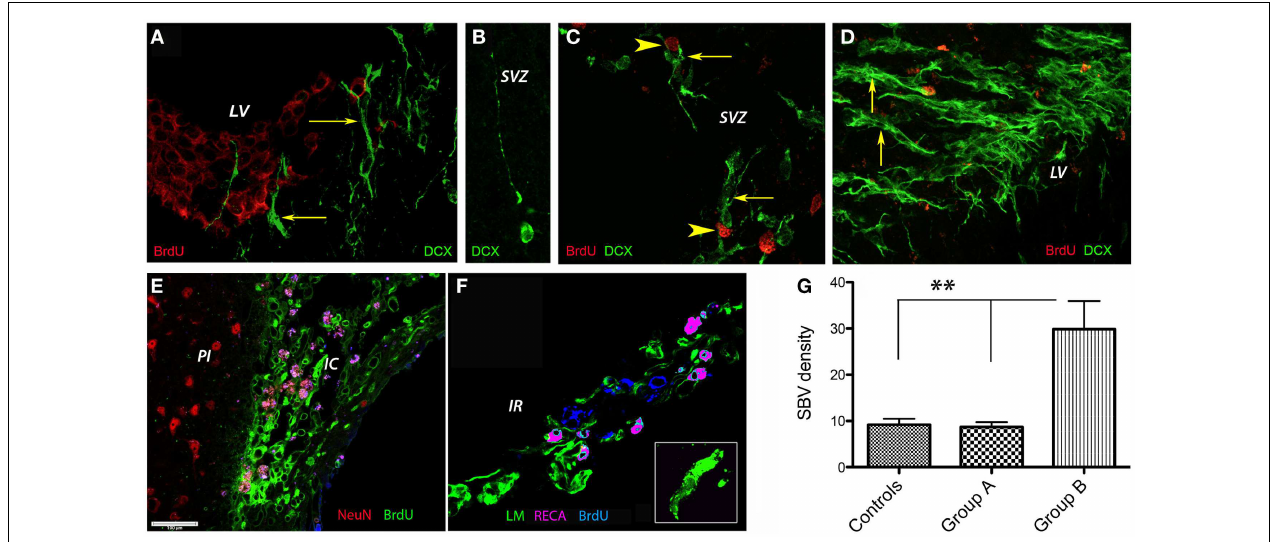
green].The border to the healthy brain region was abruptly demarcated to the left by NeuN-positive nuclei [ (E) , red]. Beyond the formerly infarct core, we noted vigorous sprouting angiogenesis as evidenced by RECA/BrdU double positive blood vessels [ (F) , violet] as well as numerous BrdU + nuclei in the newly formed endothelium [ (F) , blue] and reconstruction of the basal lamina [ (F) , green] during the resolution phase of angiogenesis. By number of laminin/BrdU co-localizations, the density of the newly formed blood vessels was significantly higher (threefold, p = 0.01) in the brains of animals treated with the combination G-CSF + BM MSC as compared to controls and G-CSF alone (G) . Cc, corpus callosum; IC, infarct core; IR, islet of regeneration; LV, lateral ventricle; PI,